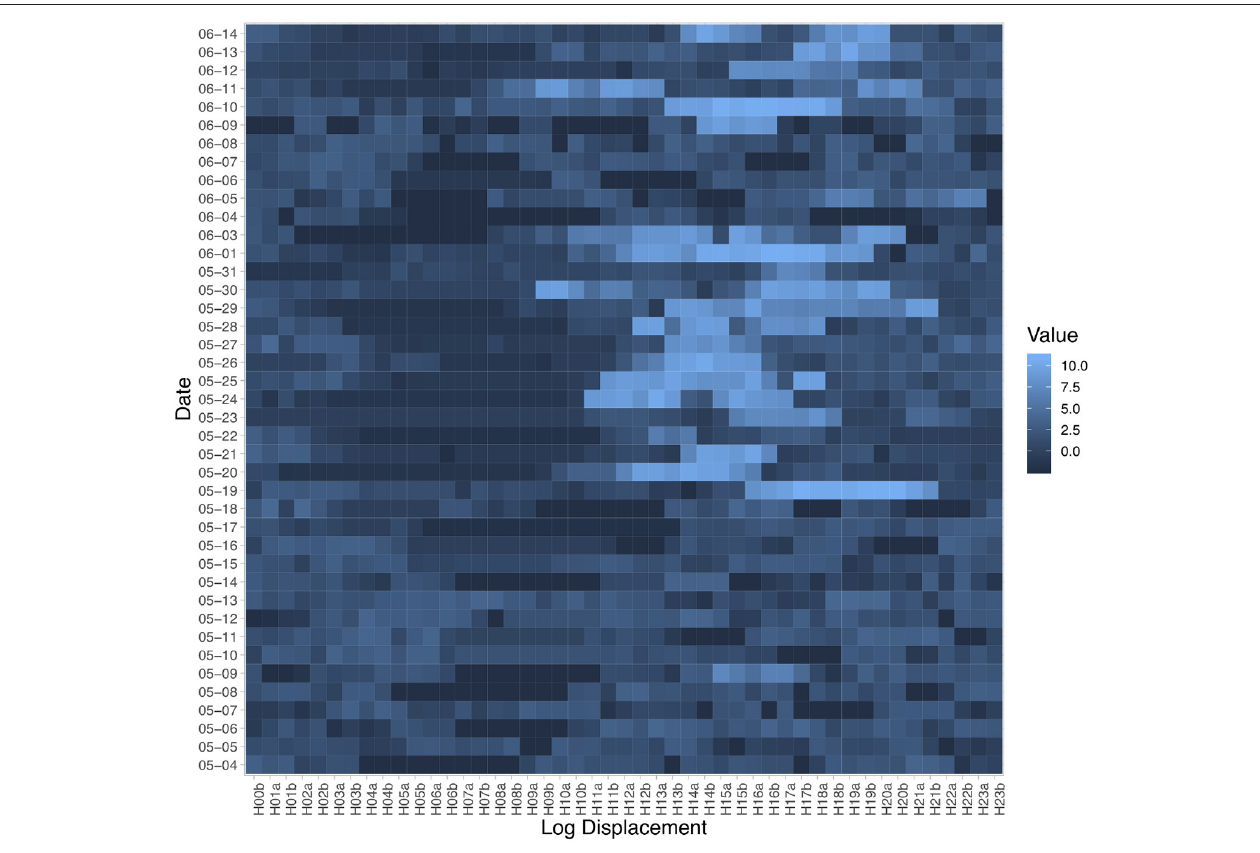
FIGURE 1 | Daily Displacement Profile extracted from one participant’s GPS data. Labels on the horizontal axis indicate the half-hour bins: for example, H06a indicates the 6-6:30 a.m. and H20b indicates 8:30-9 p.m. Cell color indicates the natural logarithm of the displacement detected by the smartphone GPS sensor during the current half-hour bin compared to the previous one. Brighter blue means greater